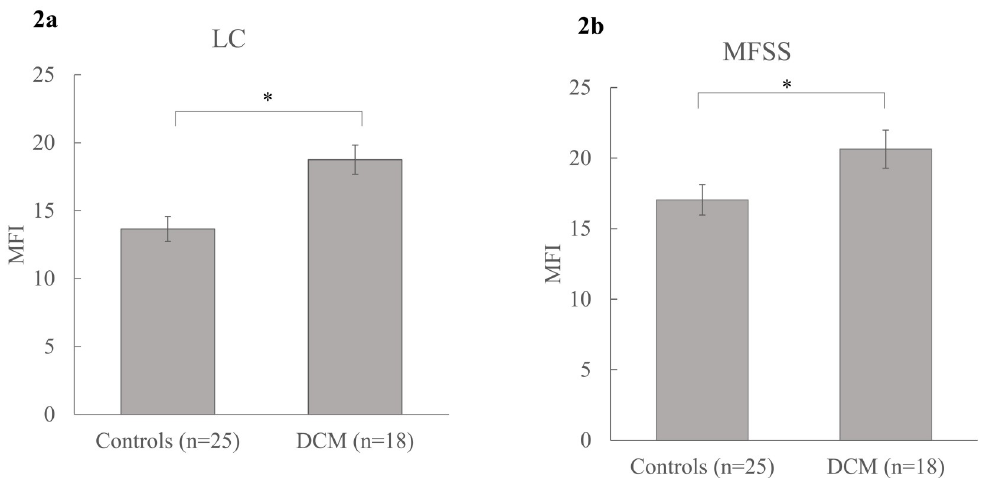
Fig 2. Mean group differences in MFI. a) MFI in cervical flexors (LC) between patients with DCM and controls; b) MFI in cervical extensors (MFSS) between patients with DCM and controls. Mean (SE) are reported. � denotes significance at p � 0.05. MFI = muscle fat infiltration, LC = longus colli and longus capitis, MFSS = multifidus and semispinalis cervicis.